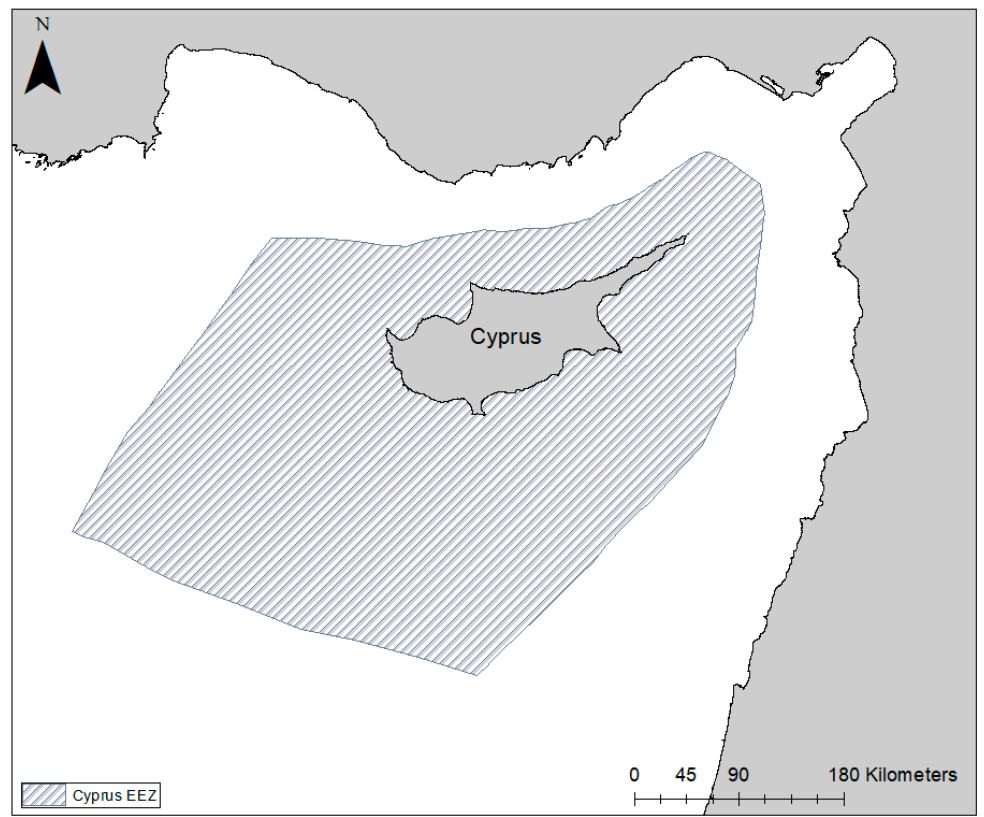
Figure 1. The Exclusive Economic Zone of the Republic of Cyprus. In the context of this study, all available information within this range was concentrated to produce an updated checklist of chondrichthyans in the region.